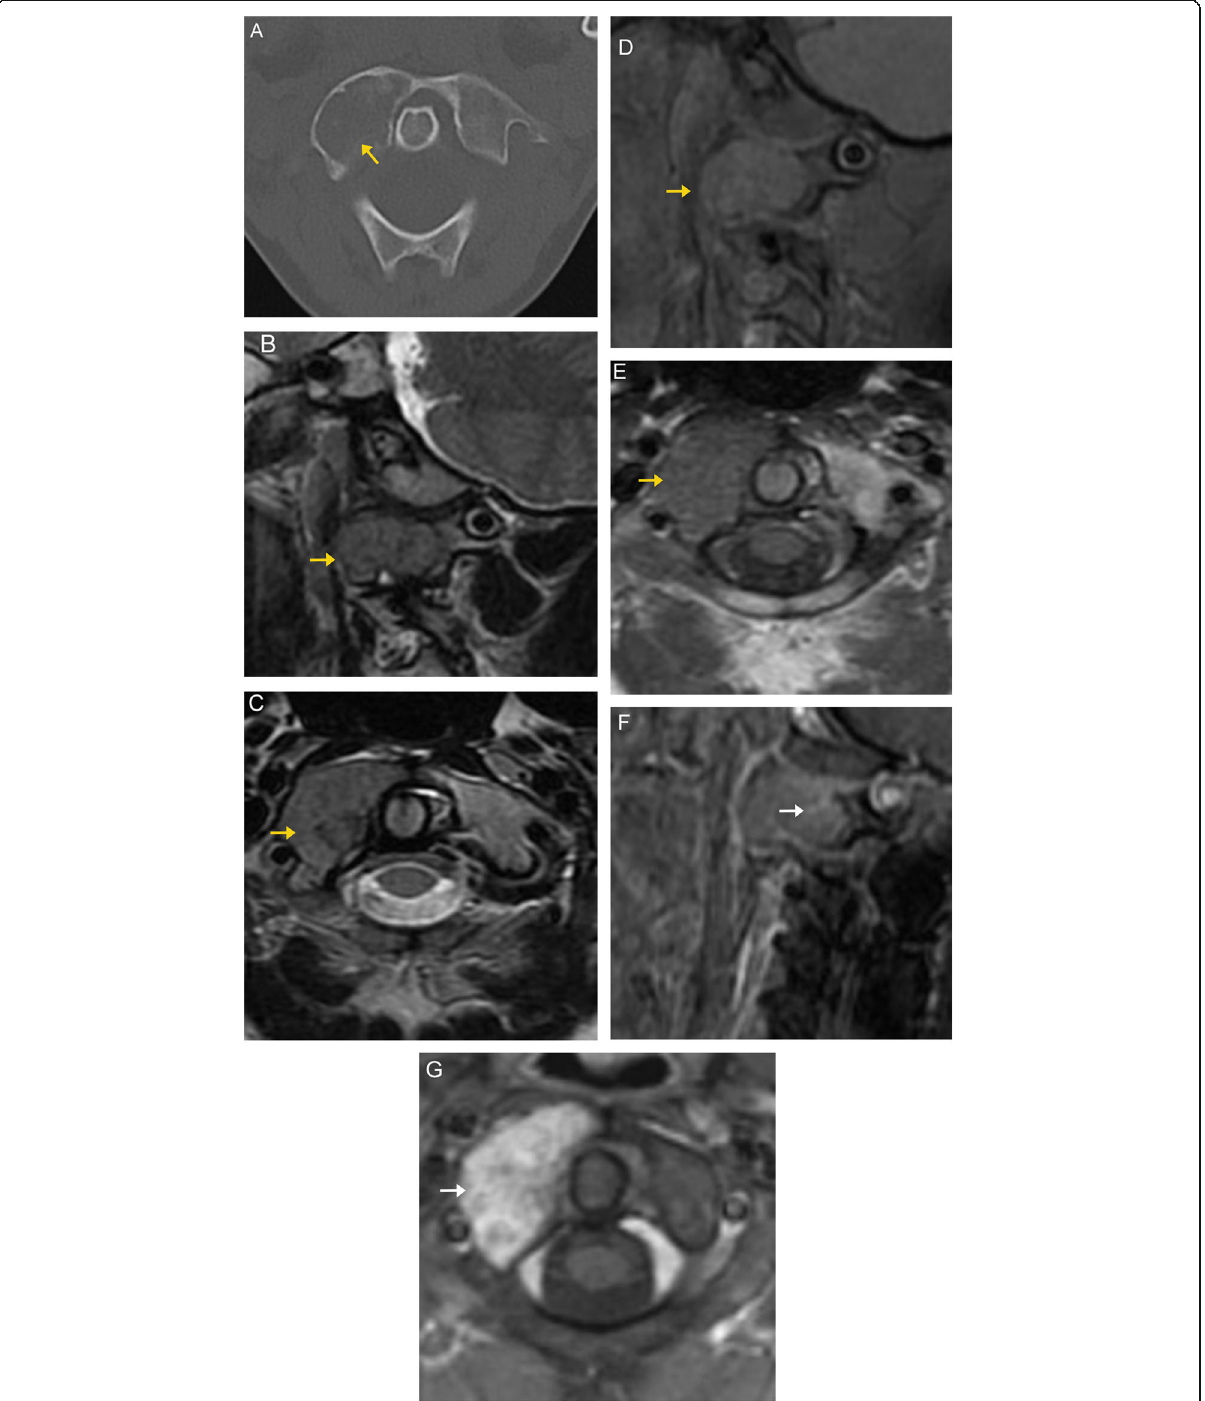
Fig. 19 Osteosarcoma. Axial bone window CT image ( a ) demonstrates moth-eaten destruction of the right lateral mass of C1 (arrow), with a wide zone of transition along the posteromedial margin. Sagittal ( b ) and axial ( c ) T2-weighted images demonstrate the lesion to be low to intermediate in signal (arrow). The lesion is also low signal on T1-weighted images ( d , e ), and demonstrates avid enhancement (arrows) on post- contrast T1 sequences ( f , g